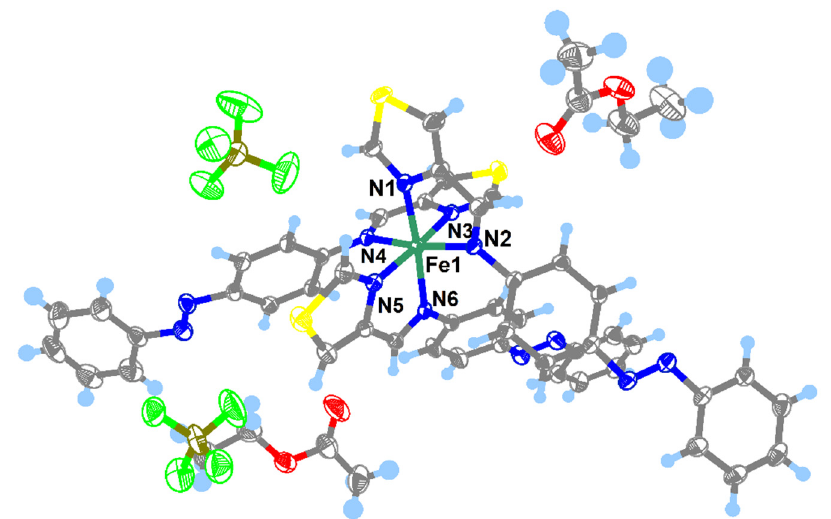
Figure 2. Asymmetric unit of Compound 1 at 150 K with thermal ellipsoids at 50% probability. Color code: Fe, dark green; S, yellow; N blue; F, green; C, gray; O, red; B, brown; H, light